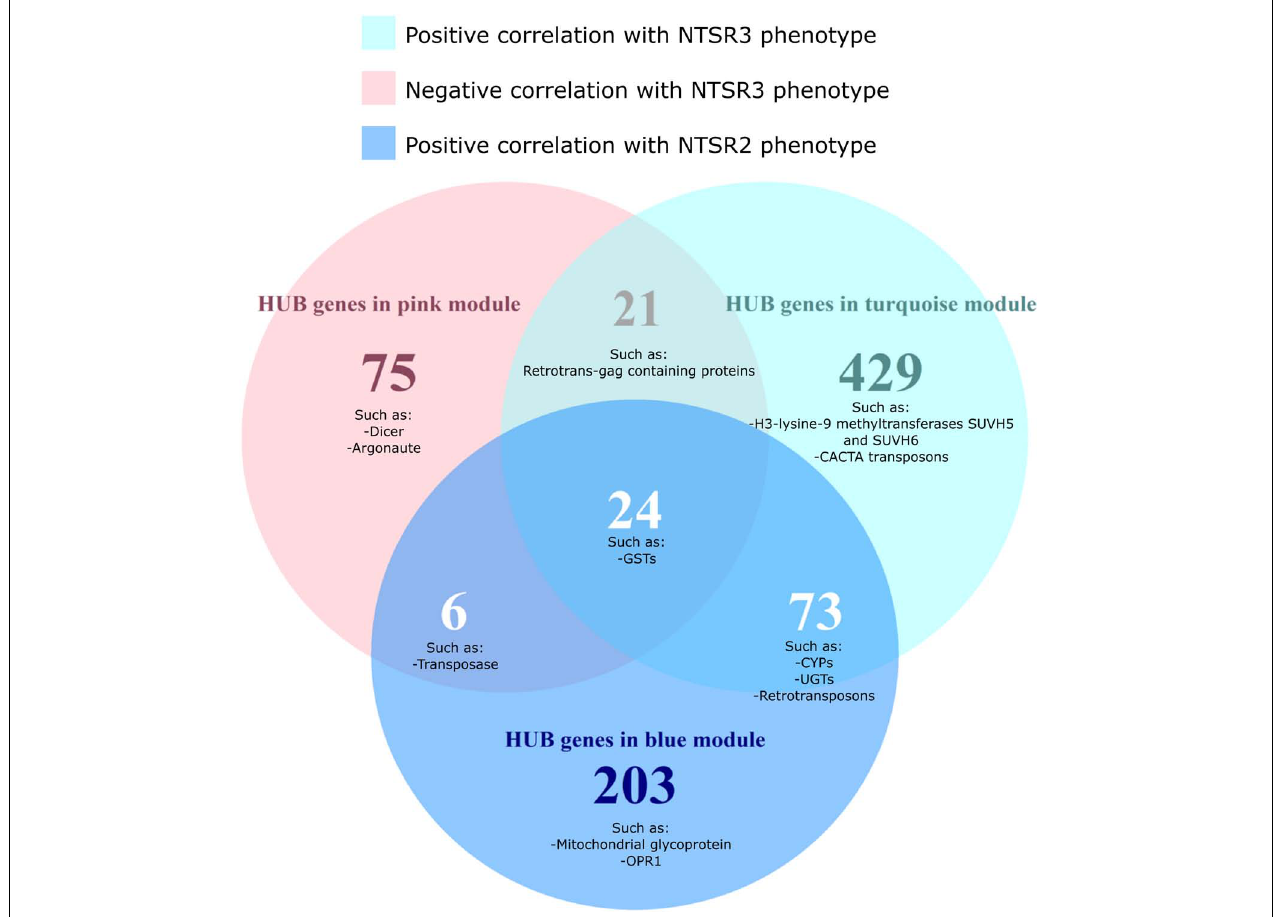
FIGURE 7 | Venn diagram of the differentially expressed HUB genes of the turquoise, pink, and blue modules grouped by the AHRD annotations. The number on each circle represents the number of different AHRD annotations. Human readable description of the common HUB genes between the turquoise (positively correlated with the NTSR3 population, pink (negatively correlated with the NTSR3 population), and blue (positively correlated the NTSR2 population) modules. HS, sensitive population; NTSR3, derived from HS and selected for resistance to fenoxaprop- P -ethyl; NTSR2, derived from HS and selected for resistance to